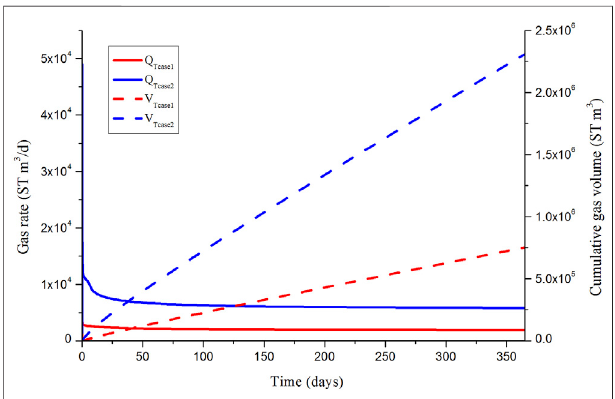
FIGURE 5 | Time-varying curve of Q Tcase1 , Q Tcase2, V Tcase1, and V Tcase2